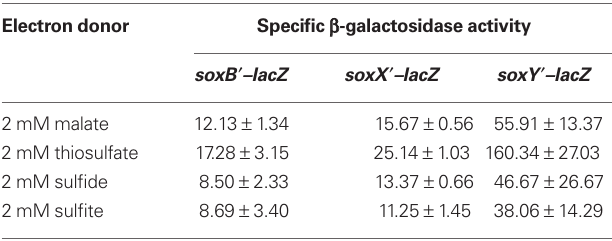
Table 4 | Expression of translational sox gene fusions in A. vinosum